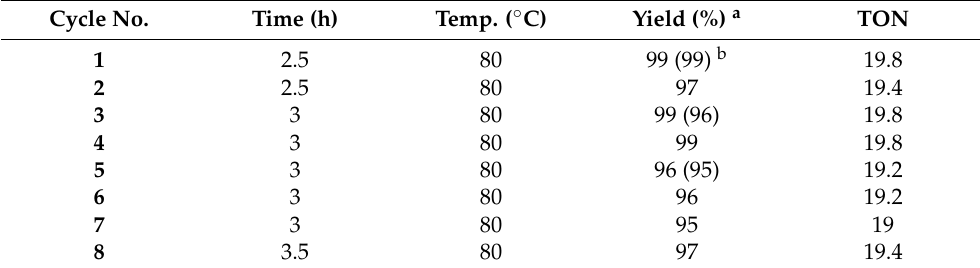
Table 3. Recycling results of A -catalyzed phospha-Michael addition of diisopropyl phosphite ( 1a ) with 2-(4-methylbenzylidene)malononitrile ( 4 ). Cycle No.